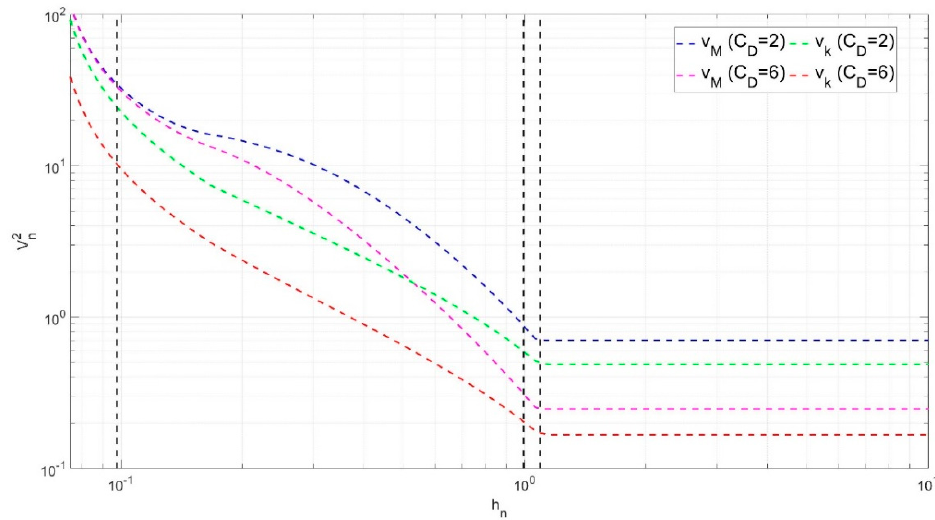
Figure 3. Theoretical instability graph: flow square velocity vs. flow height, where the flow height h n is normalized to the height of the boulder h boulder and the square velocity is normalized to gh boulder . Curves are calculated for a block of 2.95 × 3.10 × 3.00 cm (length, width and height). Each curve divides the domain into a stability (below) and instability (above) region for the boulder. Subscripts M and k represent curves derived from rotational and translational inequality formulas. The three vertical dash lines on the graph from left to right represent the flow depth when 1) the bottom, 2) the front, and 3) the top surfaces of the block are fully submerged.